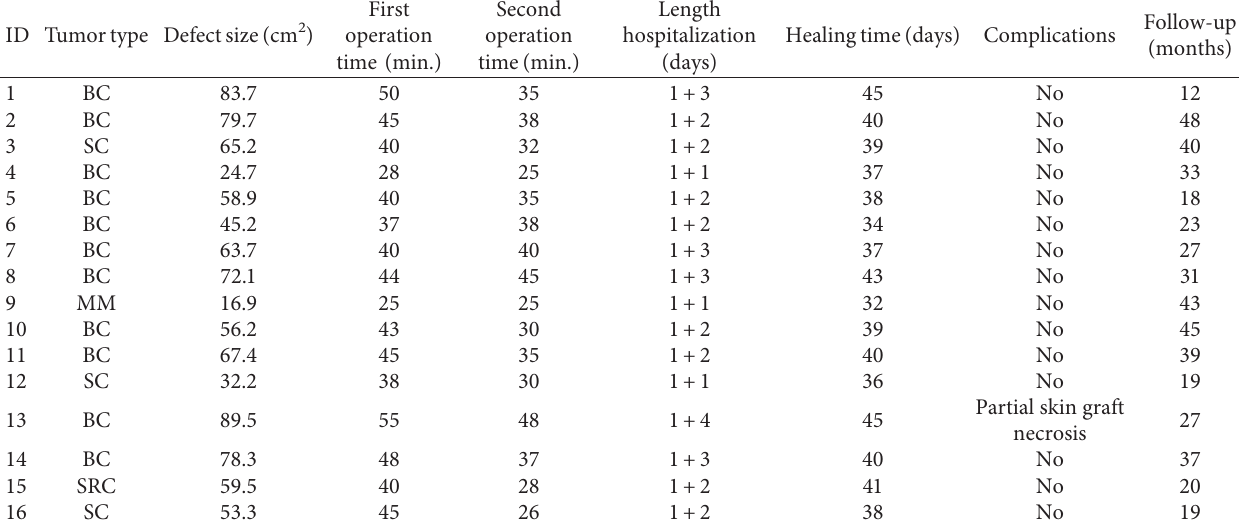
Table 1: Preoperative clinical data of the patients who underwent